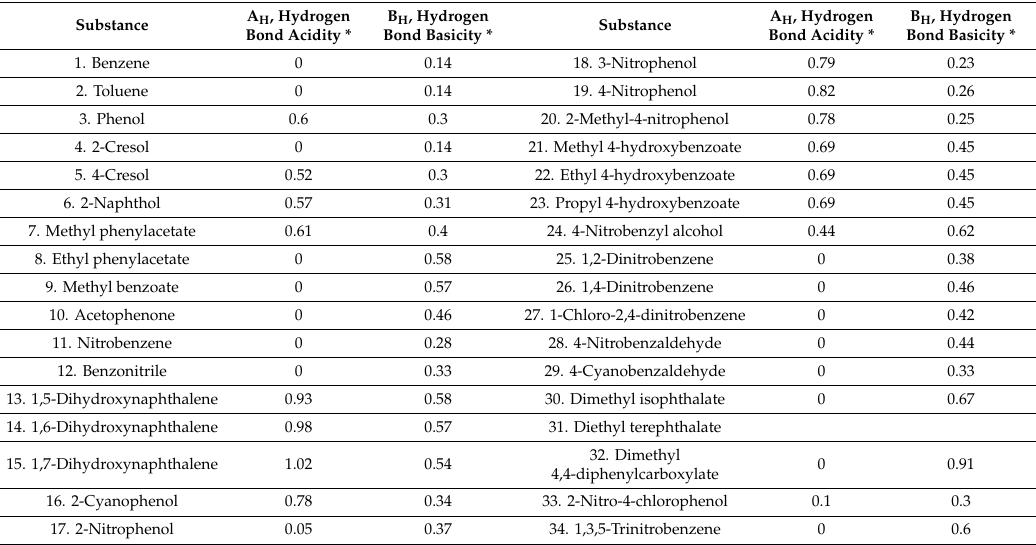
Table 2. List of investigated solutes and their descriptors [54].